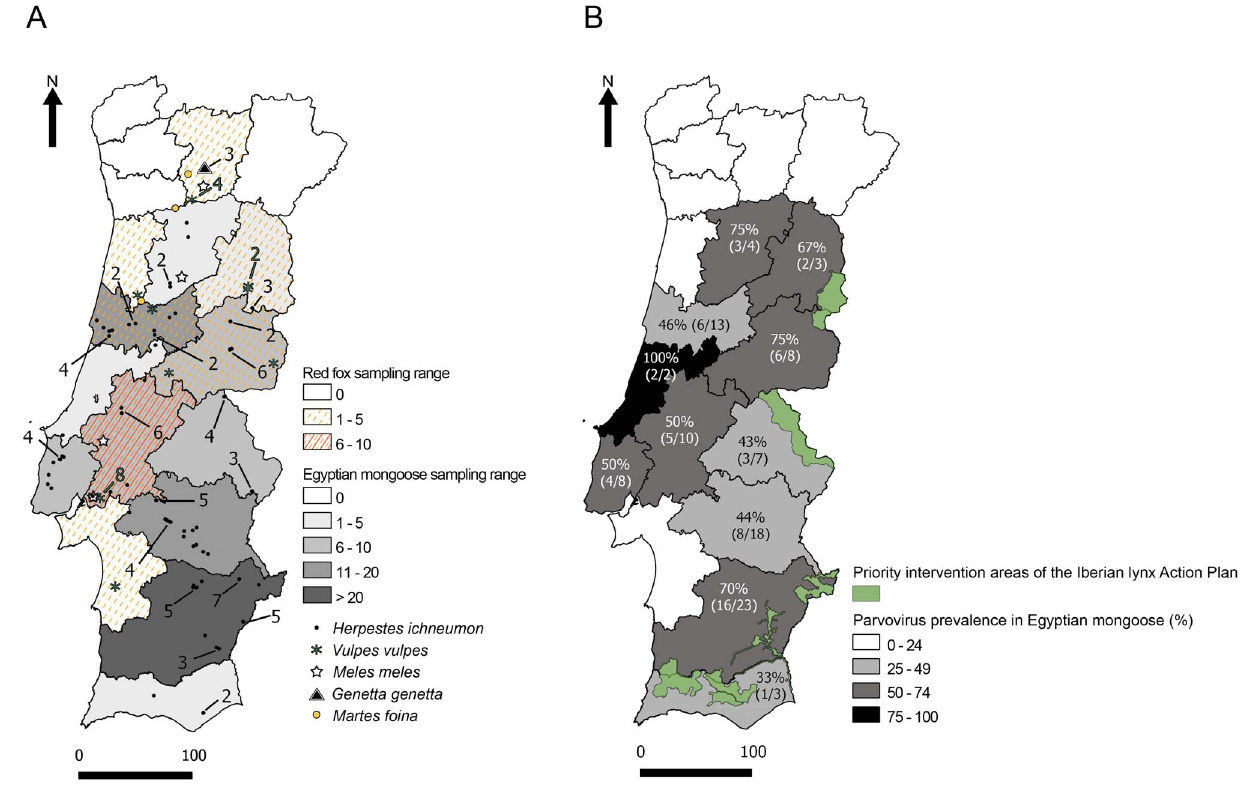
Figure 1. Geographical distribution and sampling range of animal specimens and regional prevalence rates of parvovirus in mongoose. (A) The animal species are represented in the map by symbols, as indicated. The number of samples with the same GPS coordinates (latitude; longitude) is indicated by the Arabic numbers. Thick lines separate Portugal districts. The distribution and range sampling per district of red fox and mongoose subpopulations are evidenced in orange and grey scales, respectively, as indicated. (B) Prevalence of parvovirus in mongoose per sampled district; the number of PCR-positive samples per total sampling is indicated in brackets. Priority intervention areas of the Iberian lynx Action Plan are shown in green. Figure produced with open-access software